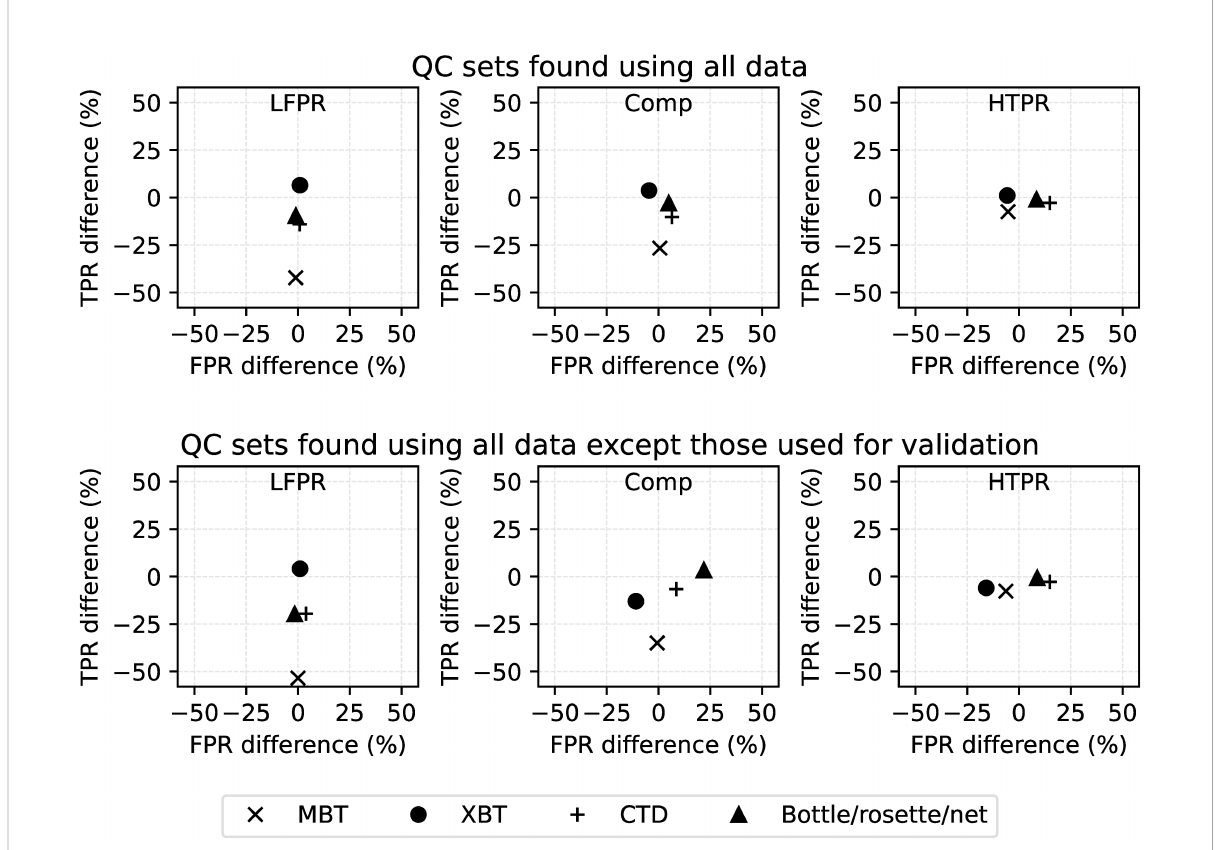
FIGURE 5 Top row: TPR and FPR calculated when applying the QC sets derived from the full QuOTA dataset to data from particular instrument types minus the TPR and FPR calculated from all the data; bottom row: as top row except the QC sets were derived from all data except those the TPR and FPR were calculated